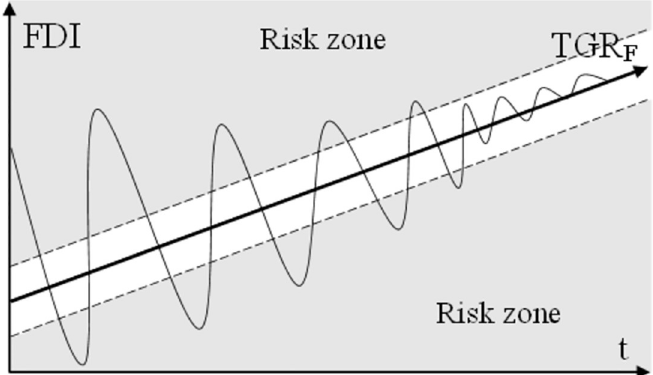
Fig 1. Regulatory zones (risk zones). Source: